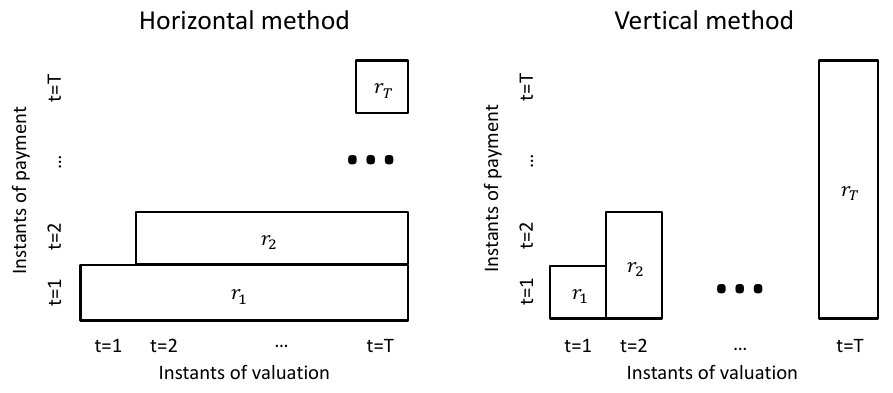
Figure 2. The two different methods of guaranteed rate